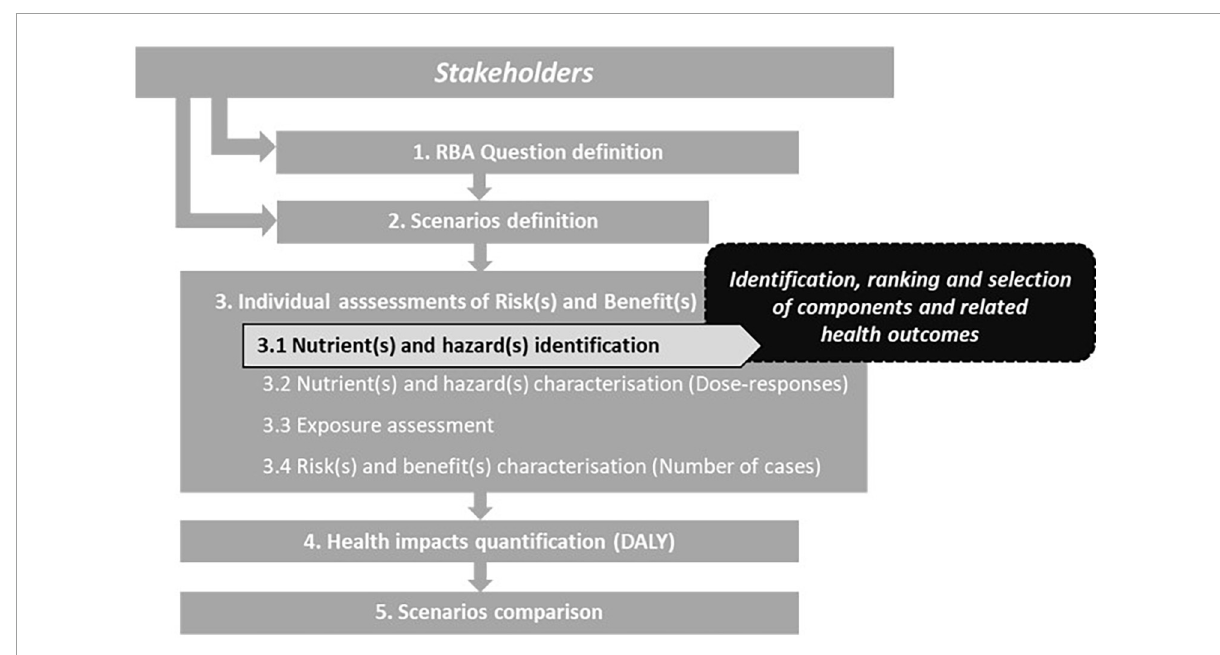
FIGURE1 Risk–benefit assessment (RBA) stepwise approach [adapted from Assunção et al. (1) and Boué